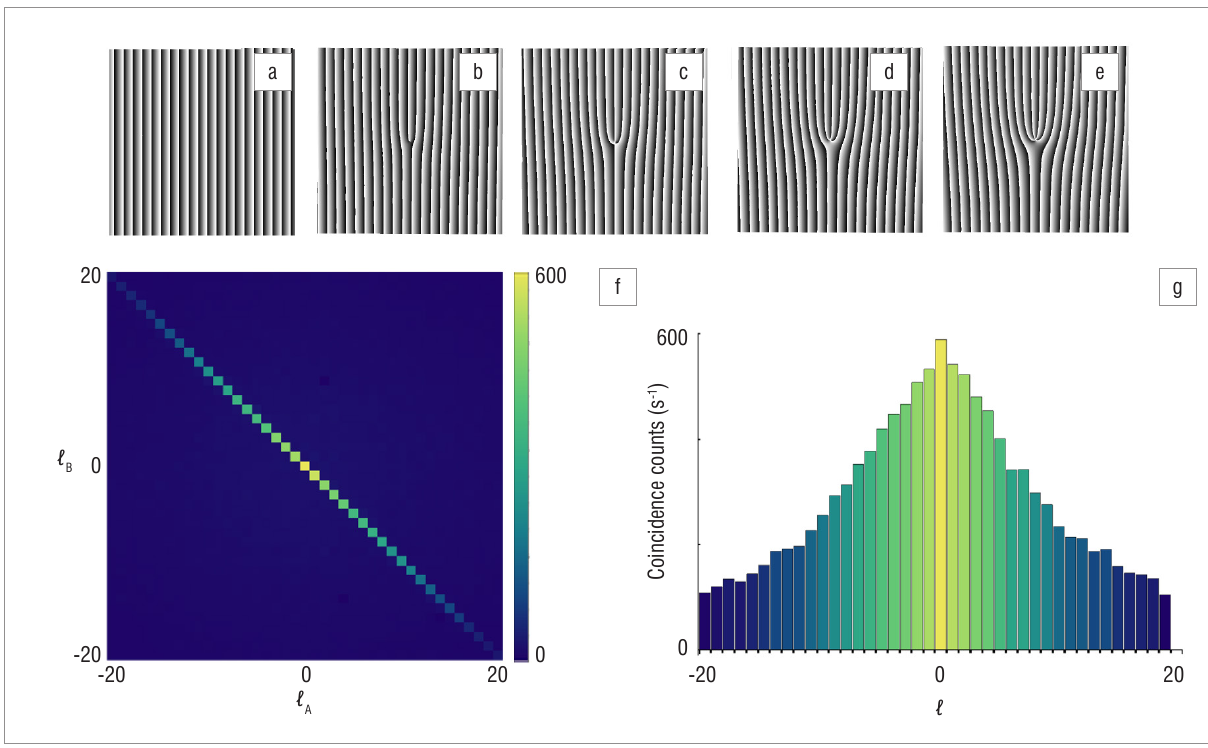
Figure 5: Experimental results of the measured spiral bandwidth. (a – e) Examples of holograms encoded onto each spatial light modulator. (f) Density plot of the measured coincidence counts per second. (g) Non-zero diagonal elements representing a spiral bandwidth plot with a full-width-half- maximum (FWHM) of approximately 15.